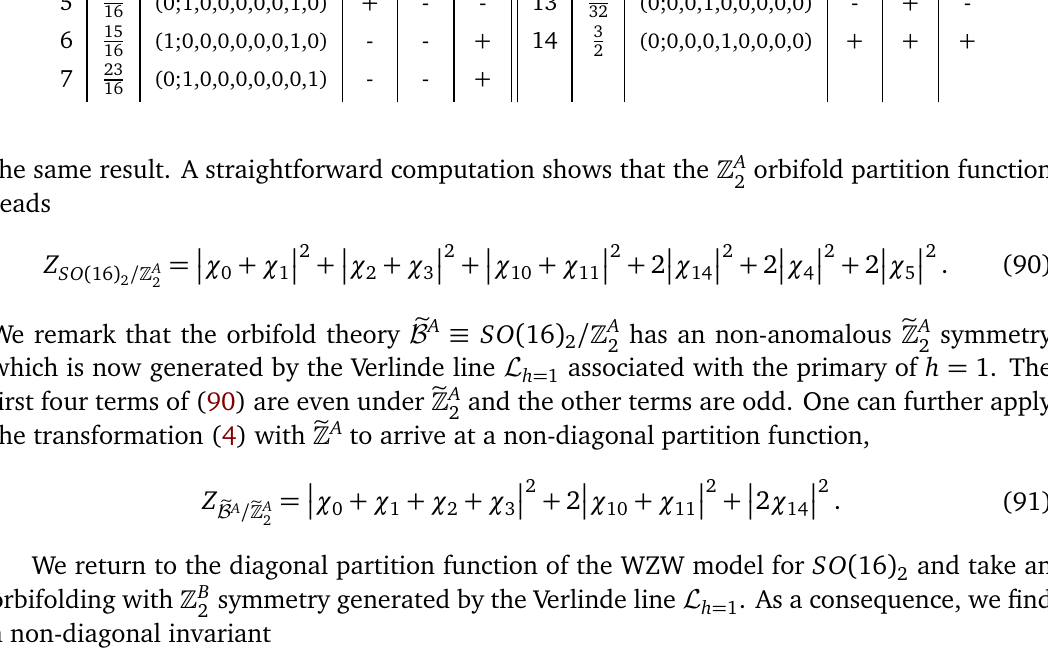
Table 26: SO ( 16 ) bels. Their characters are denoted by χ respectively. We highlight the primary related to the (cid:90)